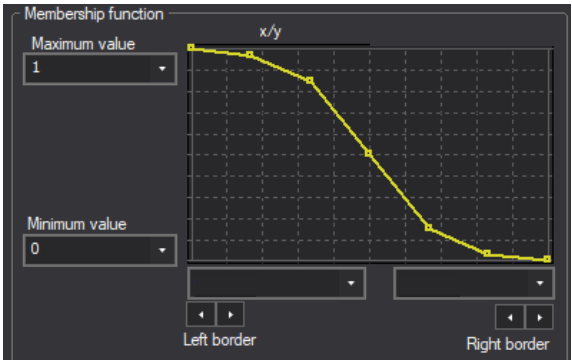
Figure 9. Second membership function (F2).